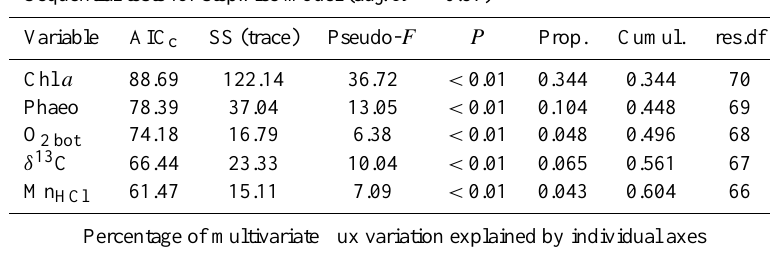
Table 6. Distance-based linear model of benthic boundary fluxes against environmental drivers determined in the southeastern Beaufort Sea in July/August 2009. Proportion of variance in benthic boundary fluxes explained by environmental variables in stepwise sequential tests following AIC c selection criterion. Chl a = sediment chlorophyll a concentration, Phaeo = sediment phaeopigment concentration, δ 13 C = isotopic carbon signature, Mn HCl = sediment surface manganese oxides concentration, O 2 bot = bottom water oxygen concentration. Prop. is the proportion of variance explained by each single variable; Cumul. is the cumulative proportion of variance explained by multiple variables; res.df = residual degrees of